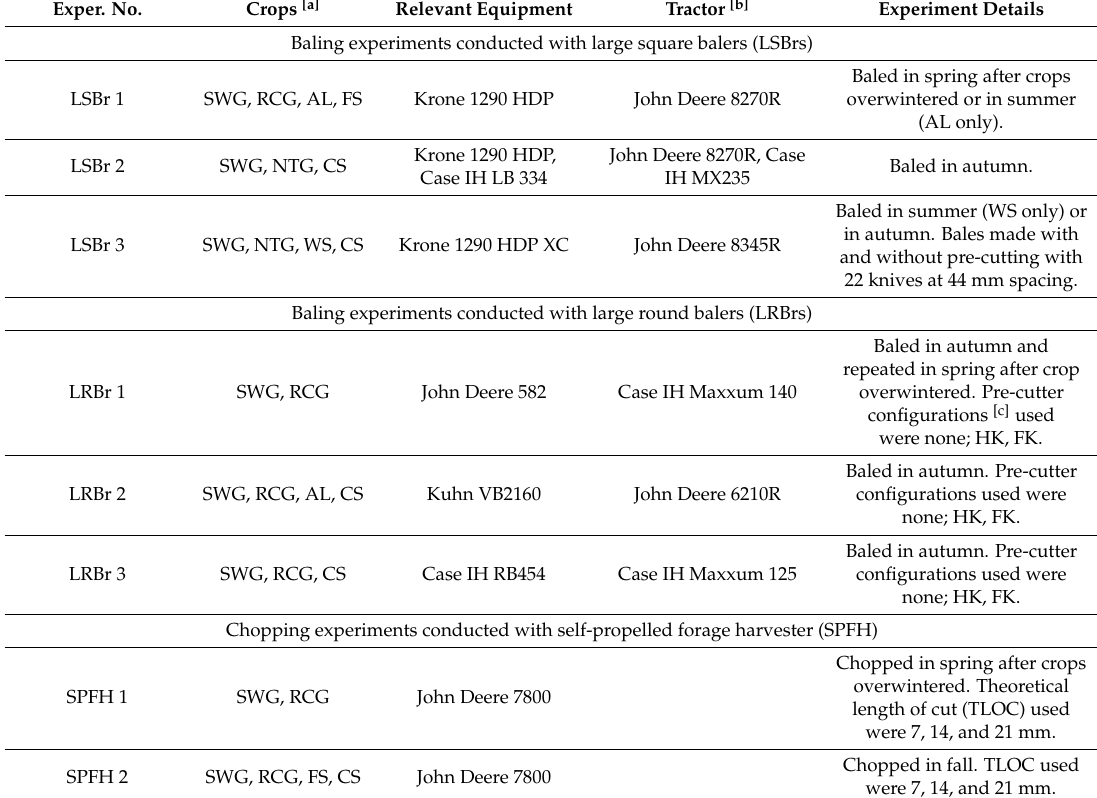
Table 1. Baling, chopping and bale processing experiments